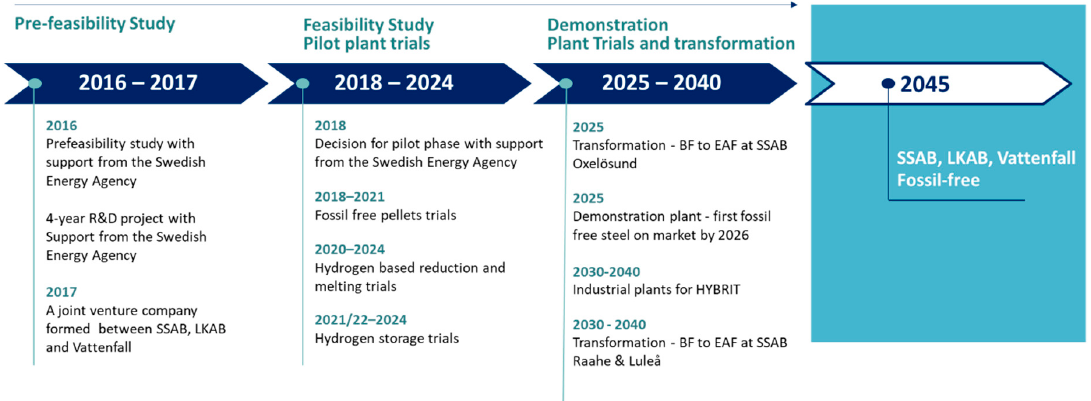
Figure 10. Roadmap to replace coal/coke-based blast furnace operations with fossil-free electricity in Sweden and Finland.